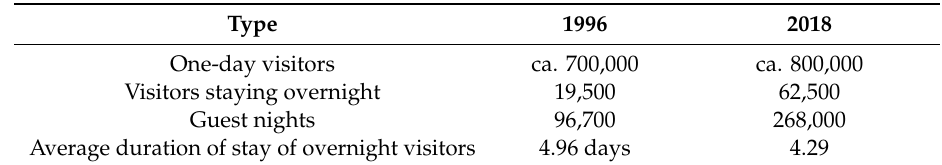
Table 2. Tourist data for facilities of the Zweckverband Lausitzer Seenland Brandenburg (Germany) in 1996 and 2018.